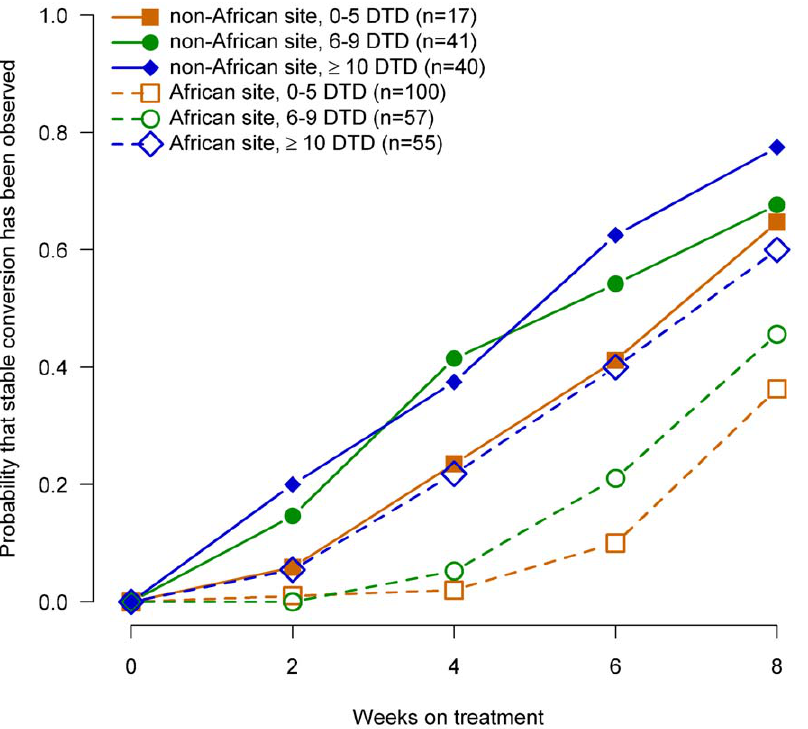
Figure 5. Probability of sputum culture conversion in liquid media by baseline number of days to detection (DTD) of growth in liquid media, African/non-African site and week of treatment, TBTC Study 28 protocol-correct patients.